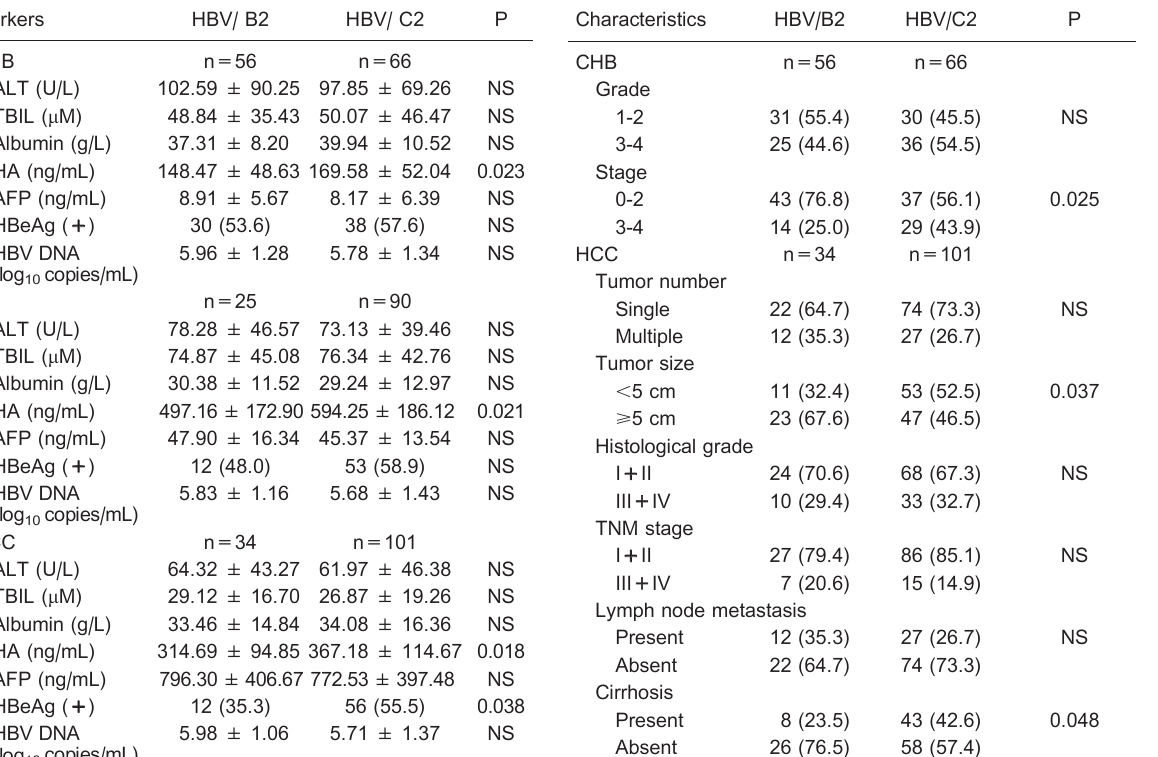
Table 3. Clinicopathological characteristics in CHB and HCC patients with HBV subgenotype B2/C2